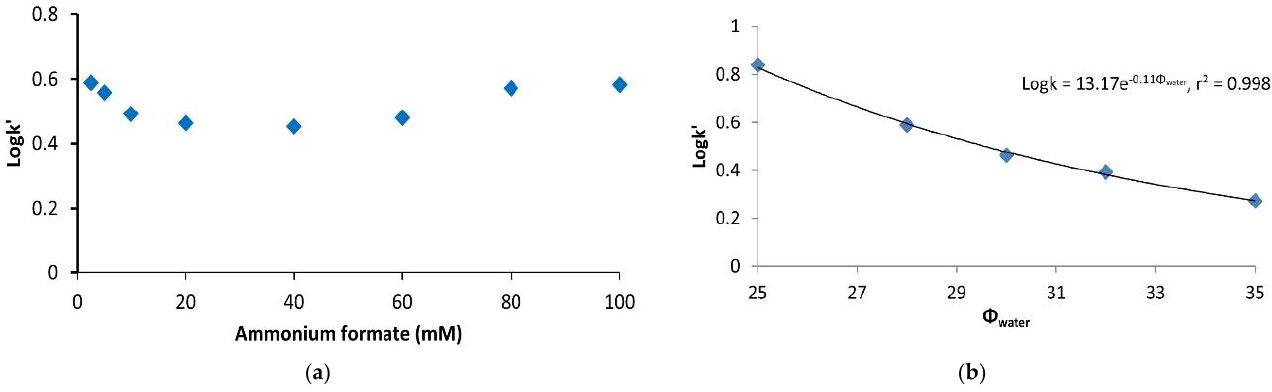
Figure 2. Plots of logk values for acetyl hexapeptide-8 as a function of: ( a ) the concentration of ammonium formate, and ( b ) the percentage of the water content of the mobile phase.